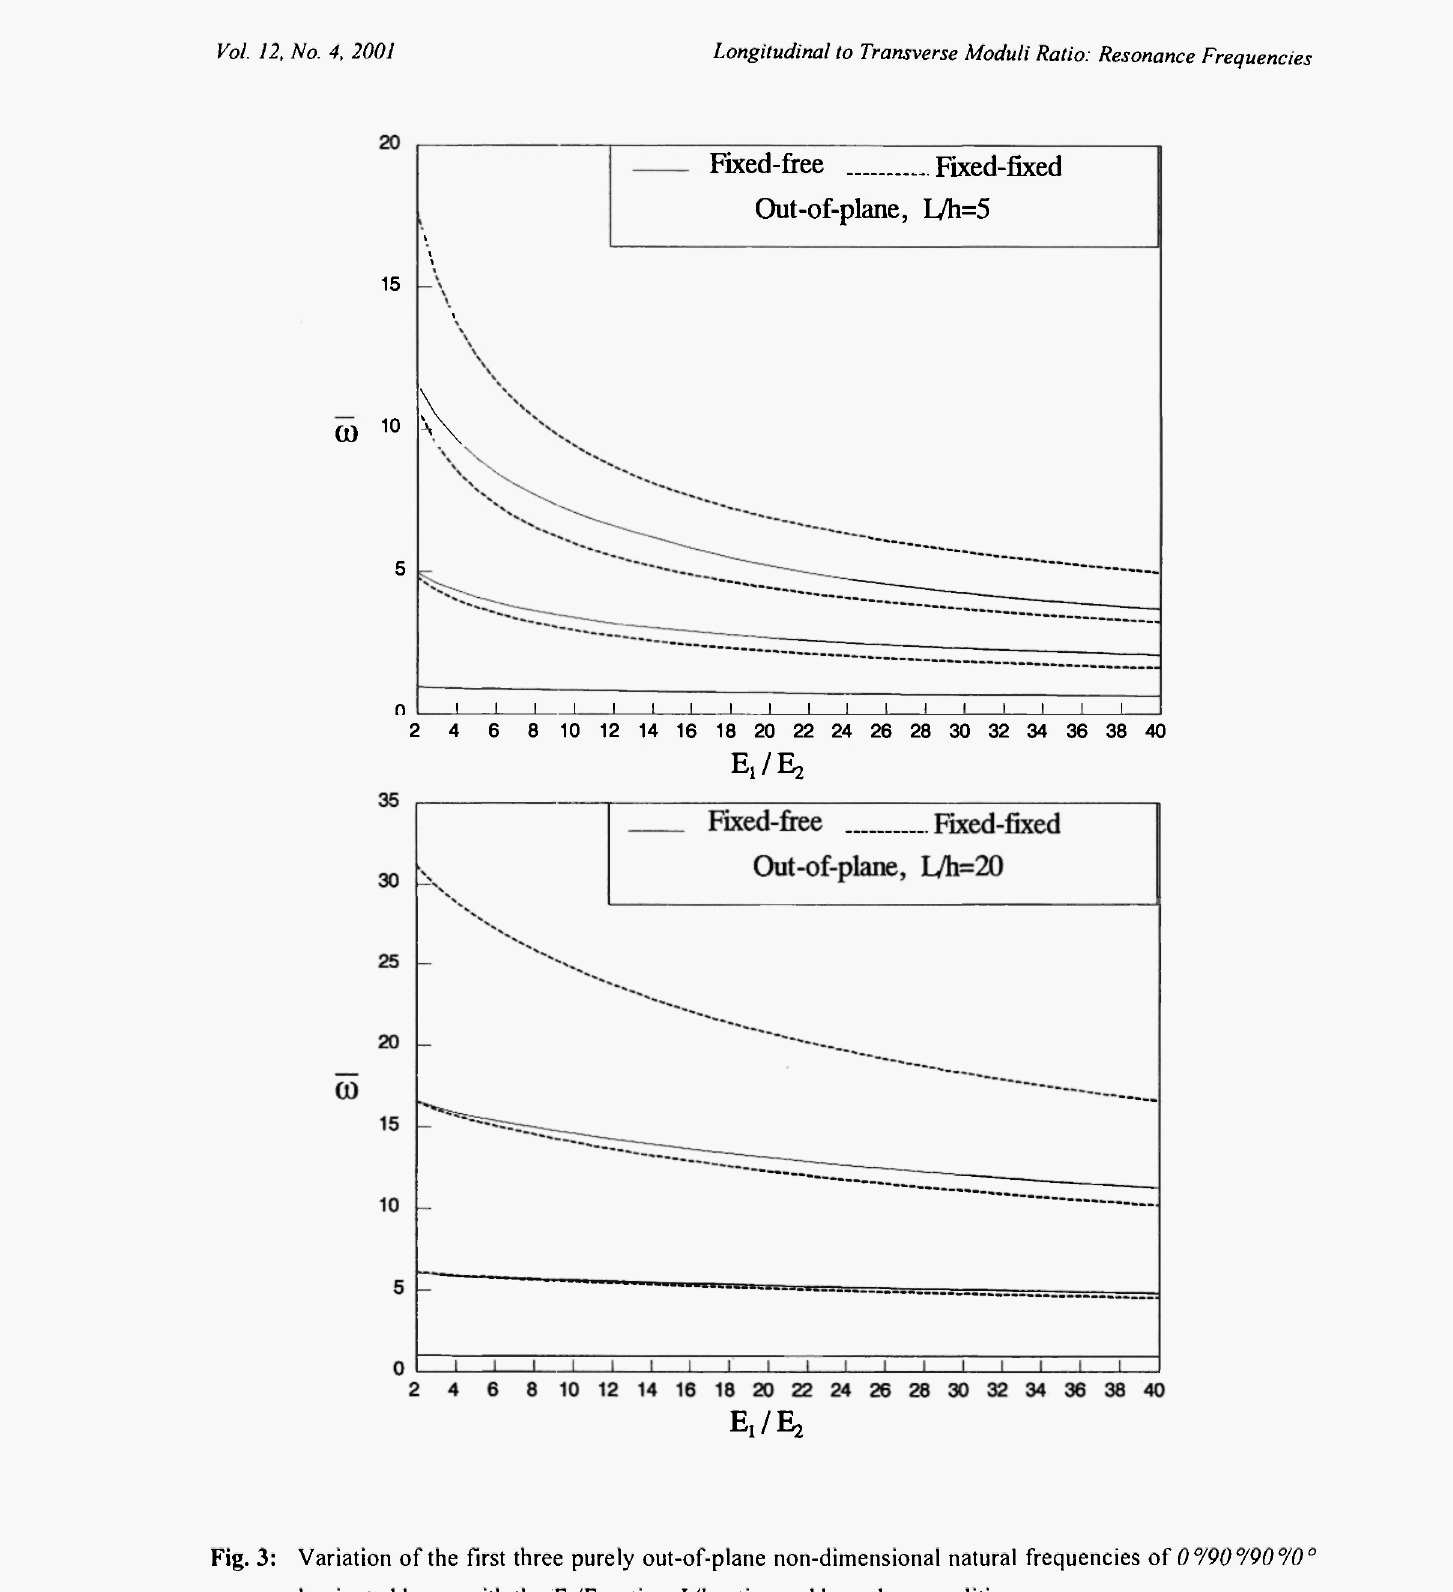
Fig. 3: Variation of the first three purely out-of-plane non-dimensional natural frequencies of 079079070° laminated beam with the E//E 2 ratios, L/h ratios and boundary conditions